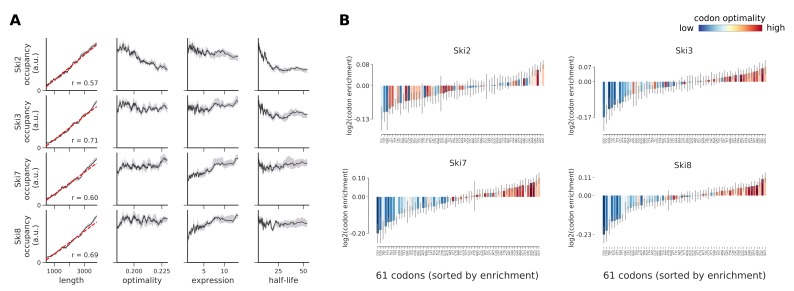
Occupancies for components of the Ski complex (Ski2, Ski3, Ski7, and Ski8) compared to transcript length, optimality, expression level, and half-life.(A) To understand binding specificity of factors in the Ski complex, the total occupancy of each factor on a transcript is plotted against various transcript features (Gray shading: 95% confidence intervals generated by bootstrapping transcripts). (B) Same analysis as in Figure 6B: Codon enrichment shows deviations in codon frequencies of transcripts bound by a degradation factor compared to each codon’s frequency on all coding sequences. Each bar is colored according to its codon-optimality with highly optimal codons in dark red and highly non-optimal codons in dark blue. (Gray lines: 90% confidence intervals generated by bootstrapping coding sequences).